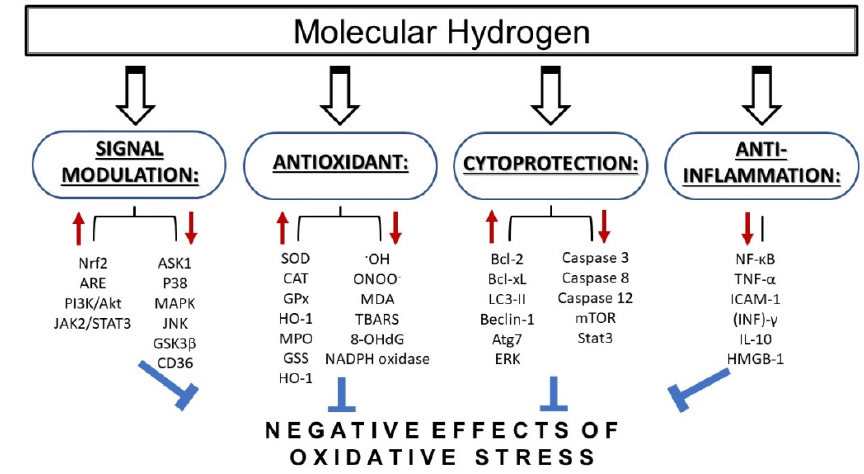
Figure 1. Mechanisms of action of molecular hydrogen in conditions of increased oxidative